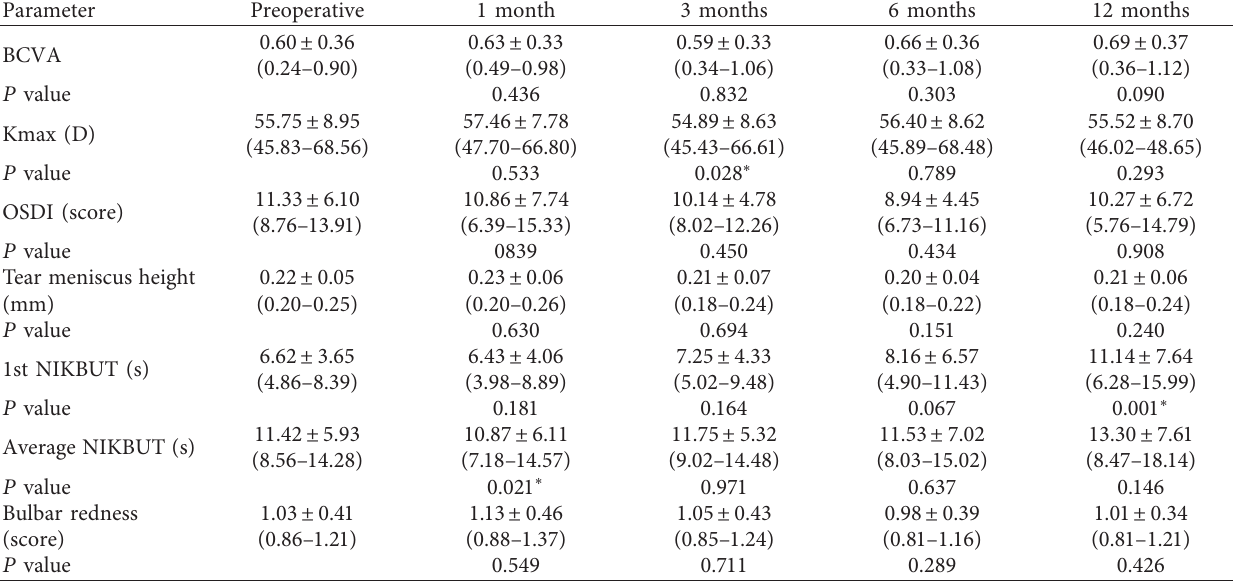
Table 1: Analysis of parameter changes in the epi-on group during the follow-up period.